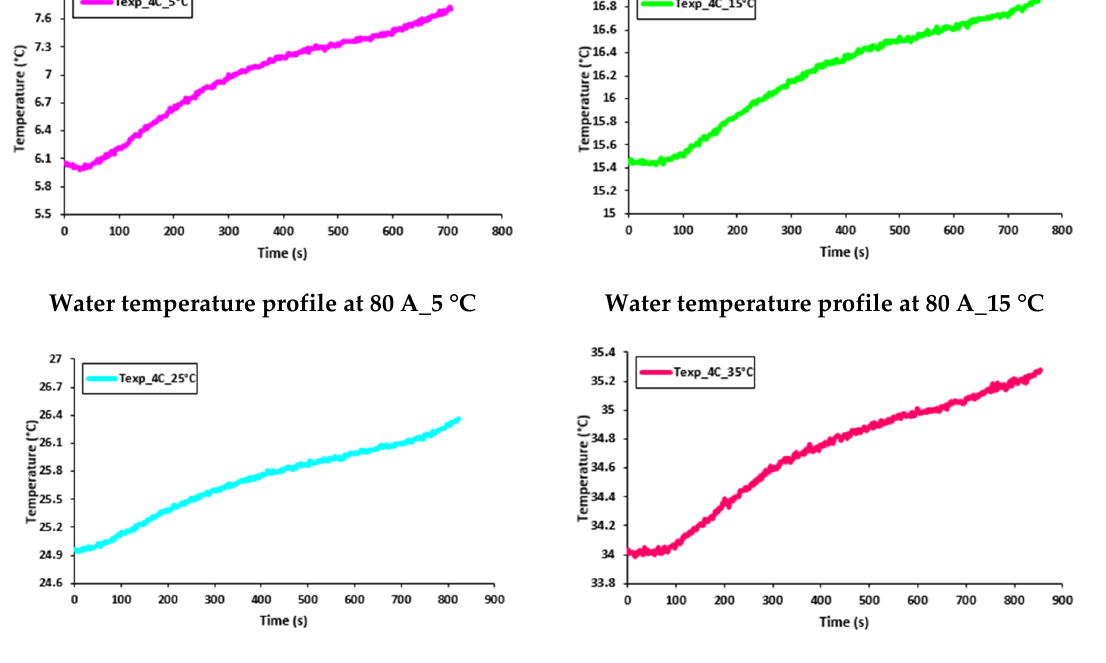
Figure 18. Transient temperature profile of water flow at 80 A with 5 °C, 15 °C, 25 °C, and 35 °C. It was discovered that the working temperature had a great impact on the battery performance.